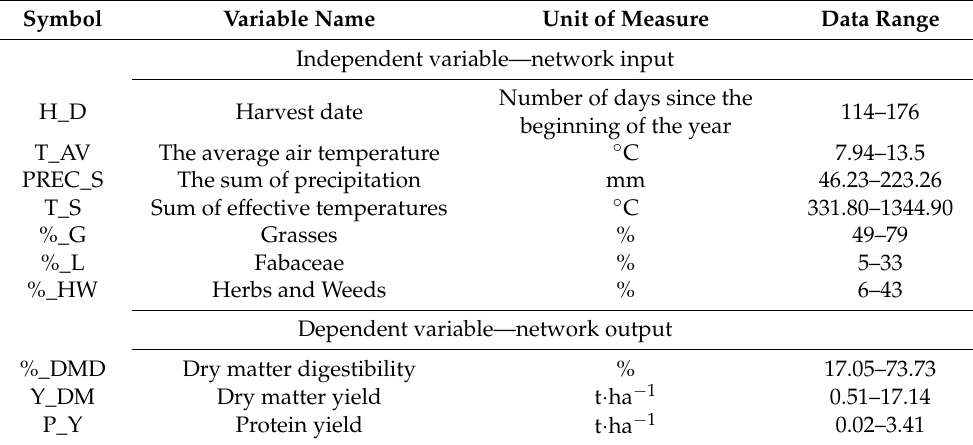
Table 2. The structure and ranges of data used for the construction of deterministic models, including the symbol of each